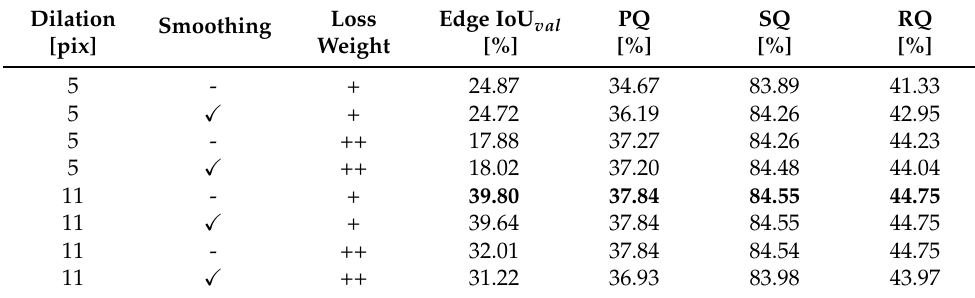
Table 2. Influence of edge ground truth (either with ( (cid:88) ) or without (-) Gaussian smoothing) and loss weighting (either strong (++) or limited (+) focus on edge pixels) on panoptic quality (PQ), segmentation quality (SQ), and recognition quality